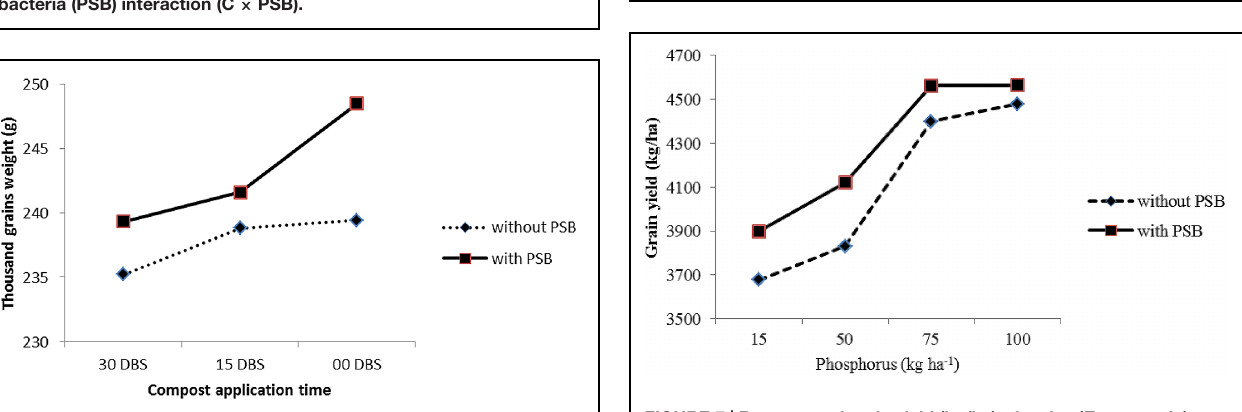
FIGURE 7 | Response of grain yield (kg/ha) of maize ( Zea mays L.) to phosphorus levels (P) and phosphate solubilizing bacteria (PSB) interaction (P ×